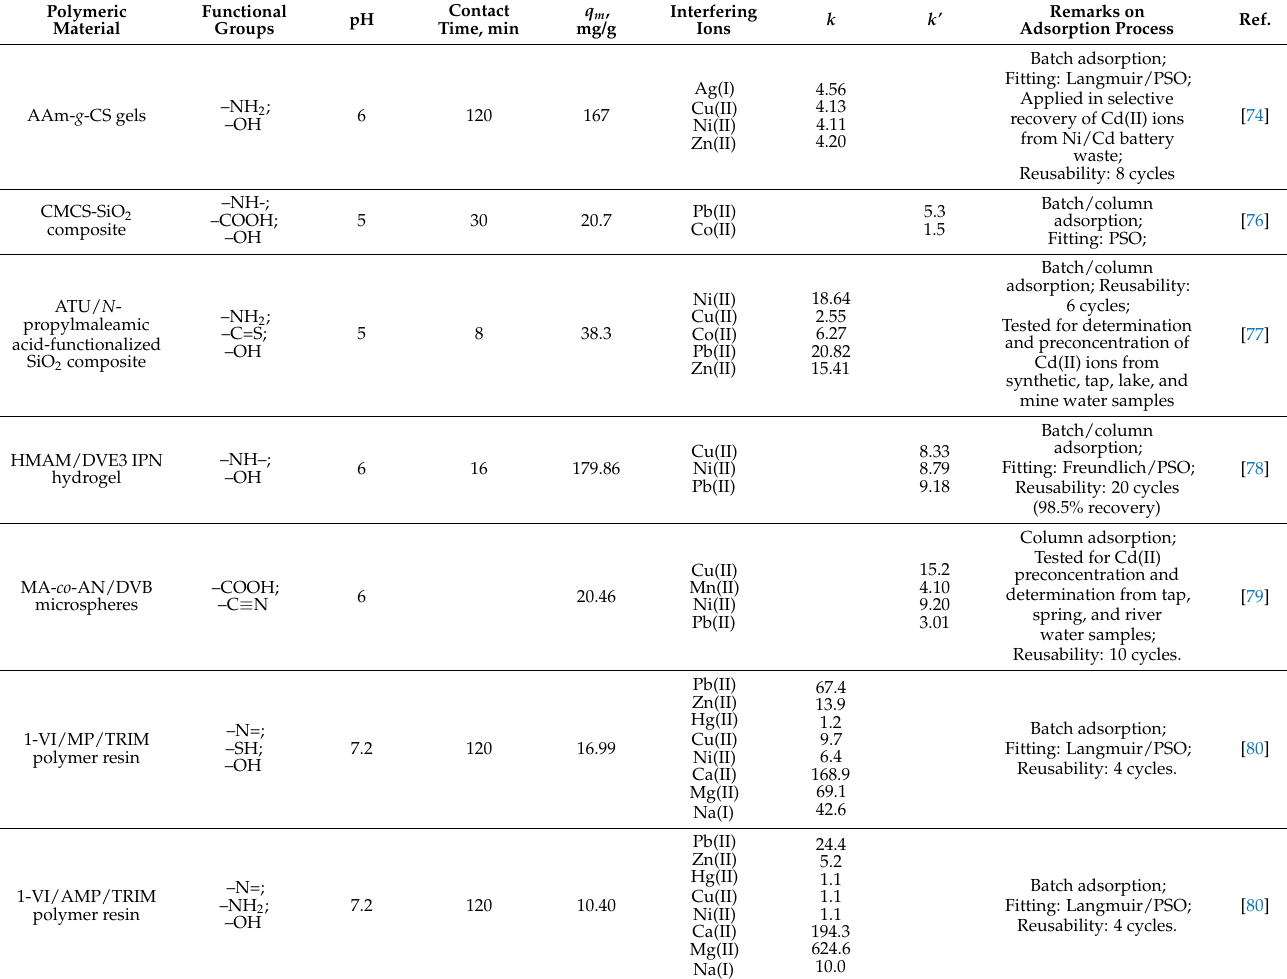
Table 3. Selective extraction of Cd(II) ions by IIPs